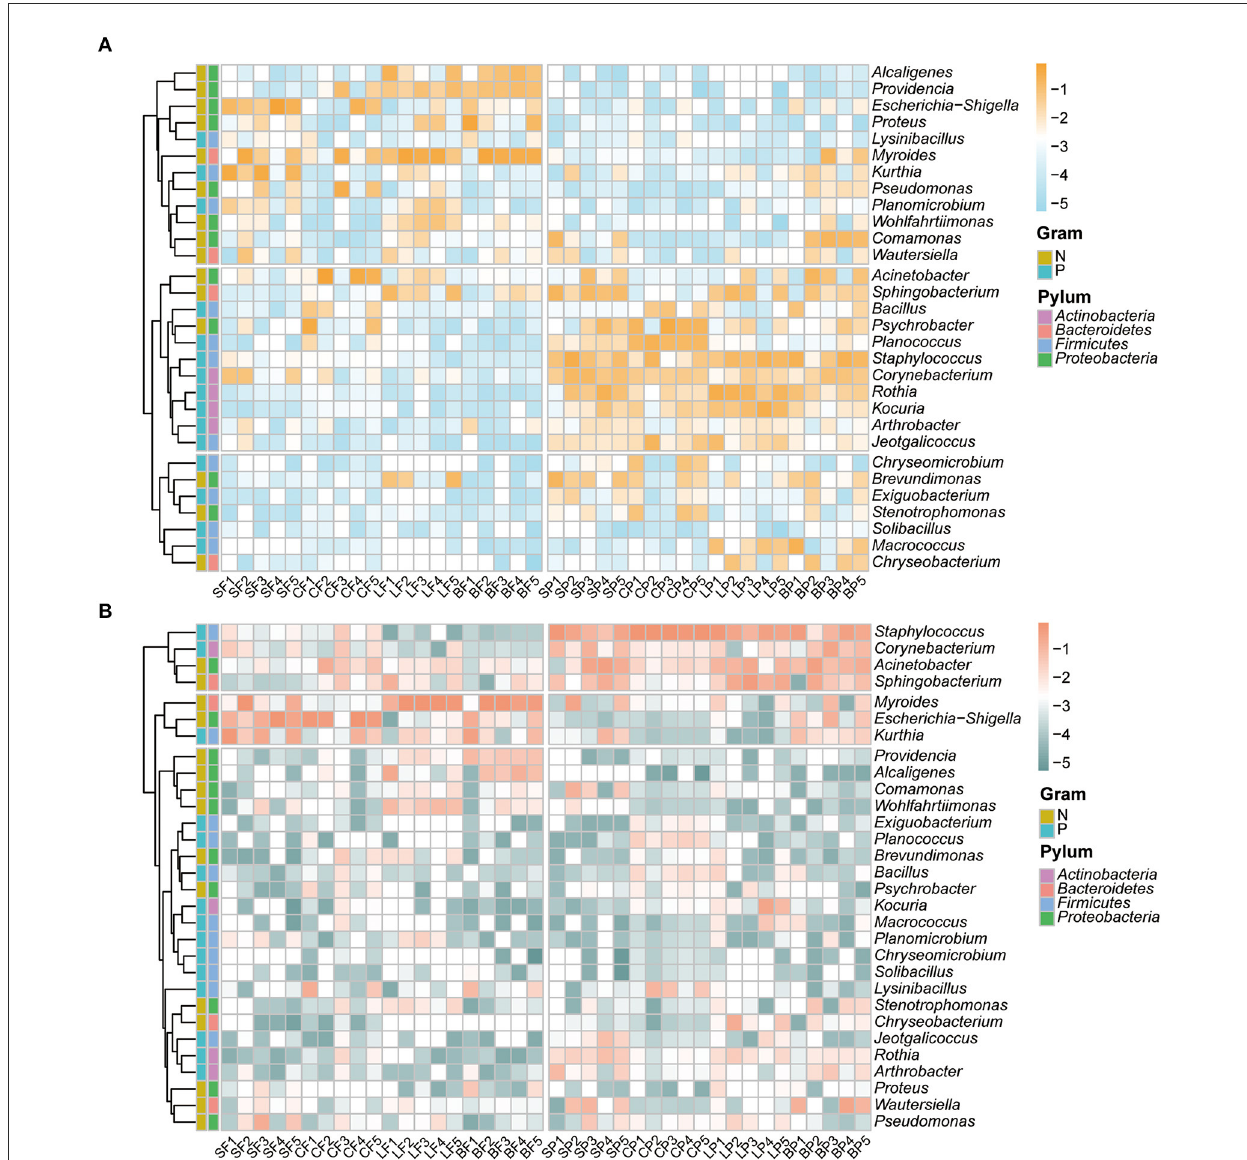
FIGURE2 Relative abundance (log 10 transformed) of top 30 erythromycin- (A) and tetracycline-resistant bacterial genera (B) in feces and fine particles by animal species. The first letter of the sample name represents the category of animals: S, swine; C, cattle; L, layer; B, broiler. The second letter represents the category of media: F, feces; P,